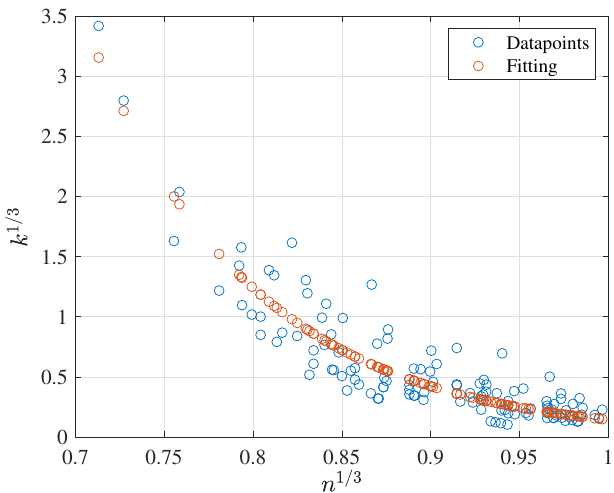
Figure 8. The final coefficients are displayed below: